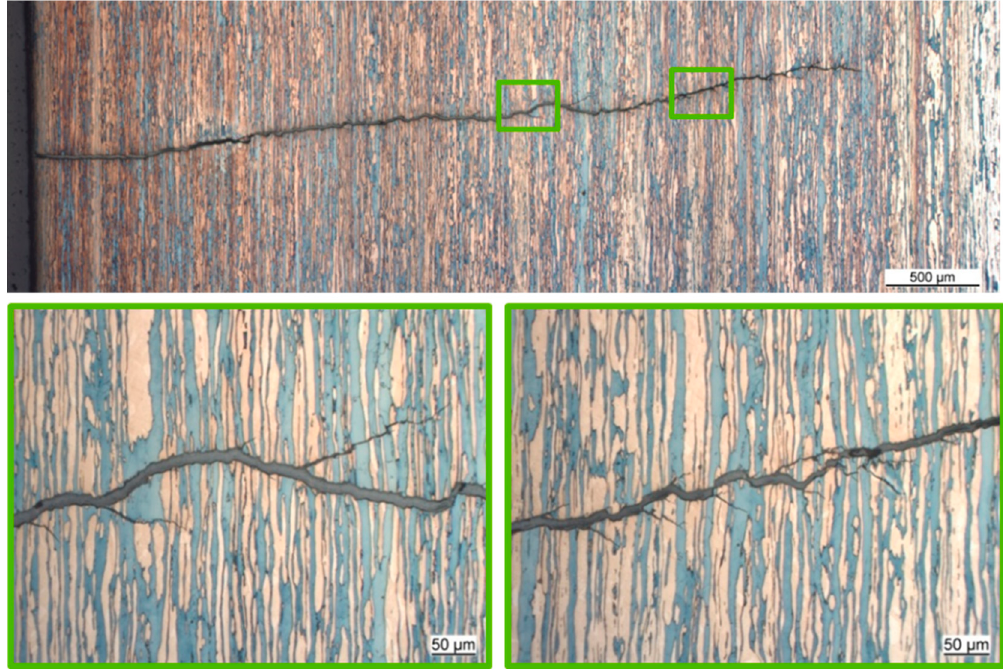
Figure 20. Microsection of macro crack with significant residual surface opening. Etchant: Beraha II ( top ) [93]. Microsections of major crack initiation ( left ) and major crack termination zone ( right ) (380 MPa; 0.36 × 10 6 cycles).